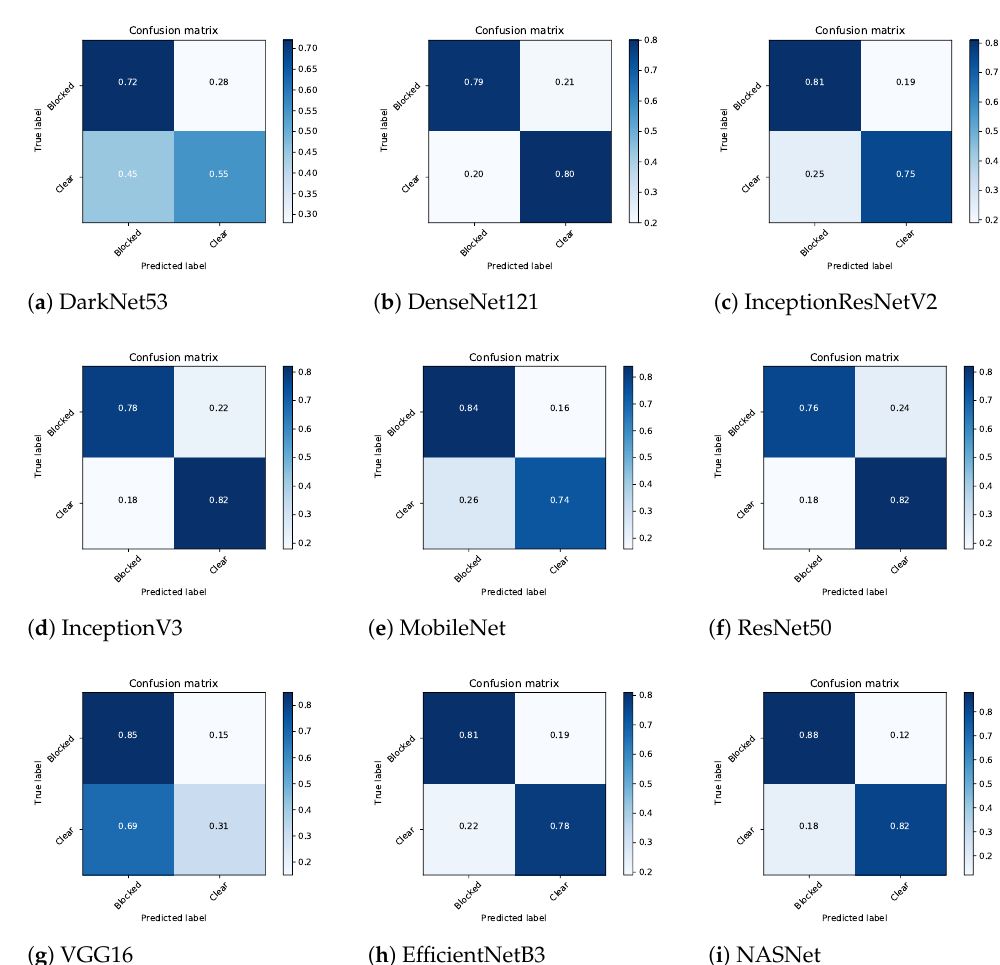
Figure 7. ConfusionmatricesofimplementedCNNmodelsforblockagedetection(5-foldcrossvalidation).